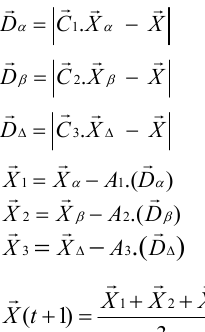
Update the location of the search agent Update the a, A and C Evaluation of the fitness function of search agents ( α , β , Δ , and ω )